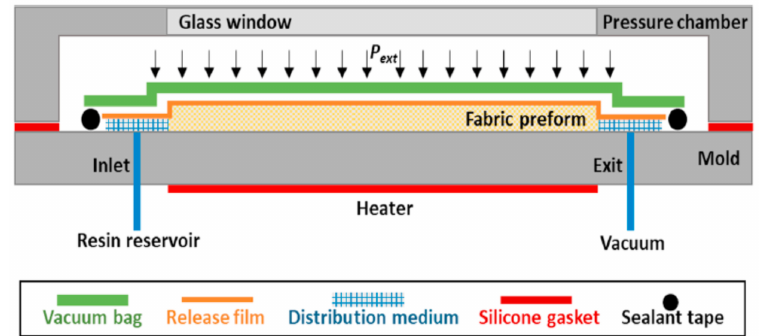
Figure 9. Pressurized VARTM Setup [74]. Reprinted with permission from